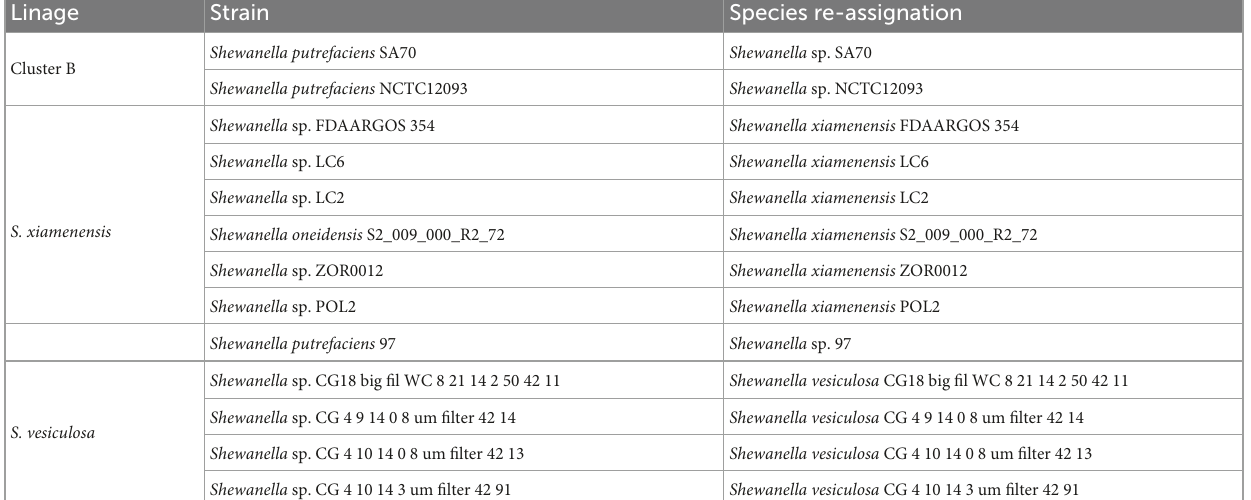
TABLE 1 Re-assignment of Shewanella spp. strains.